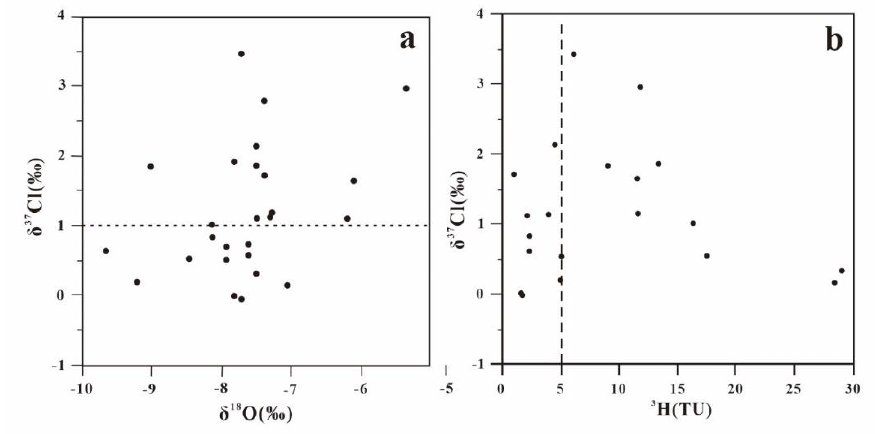
Figure 12. δ 37 Cl- δ 18 O ( a ) and δ 37 Cl- 3 H ( b ) value relationship of subsurface brine in Xishanzui.